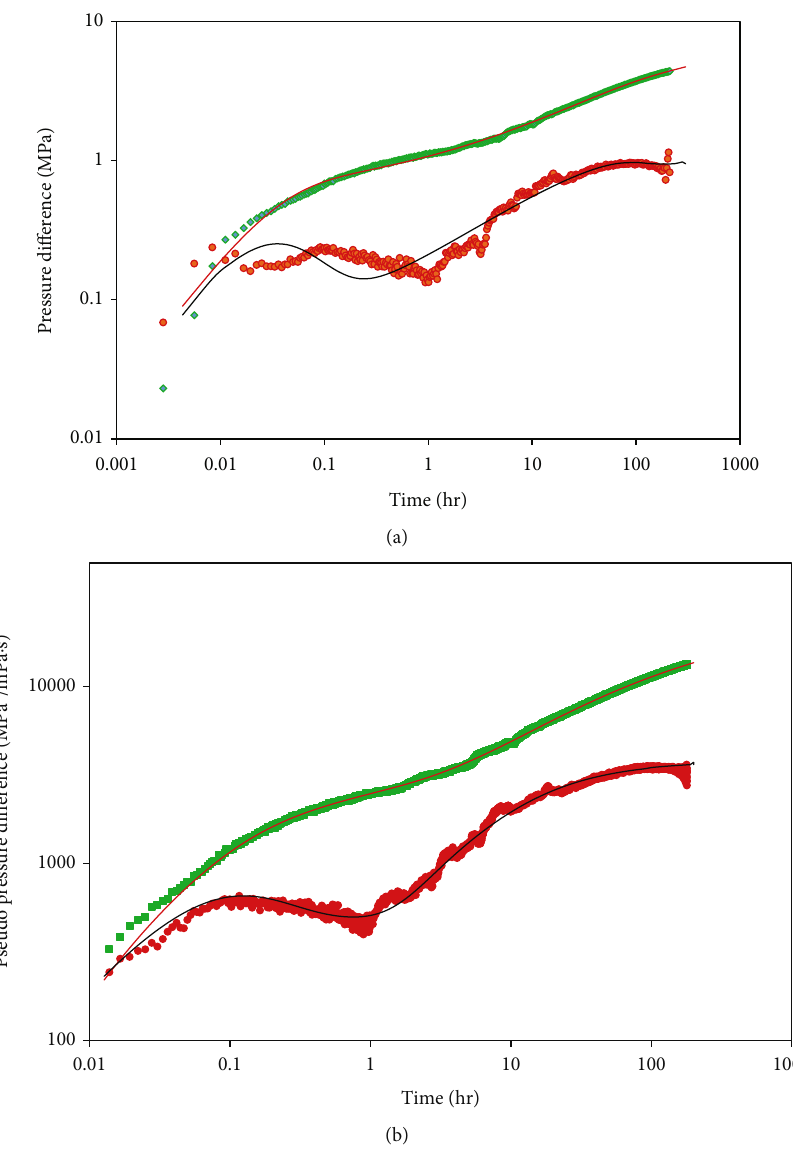
Figure 3: Comparison of pressure matching by Saphir and the model of Qin et al. Table 1: Interpretation results between commercial software and the model of Qin et al. Saphir Model of Qin et